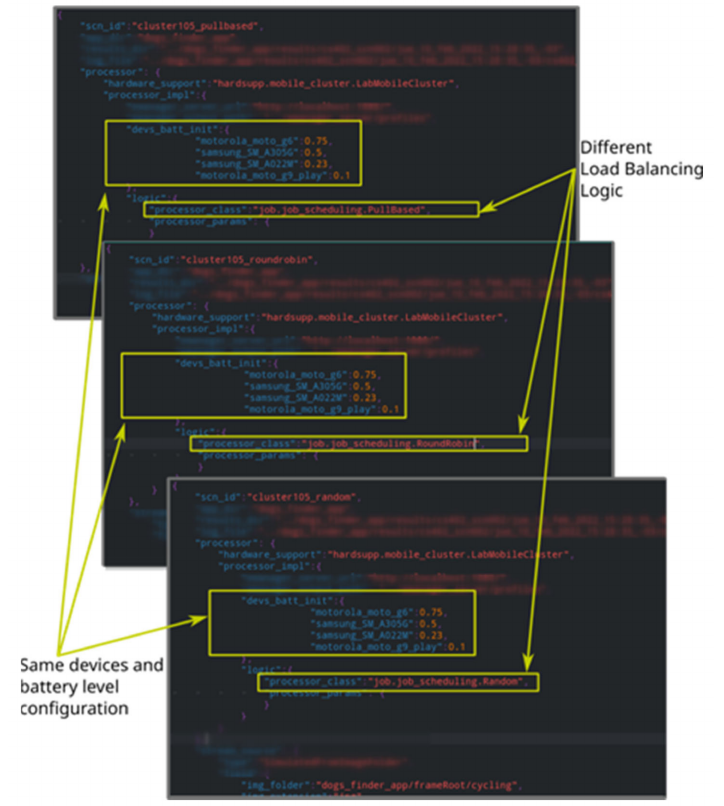
Figure 1. Synchronized test specification